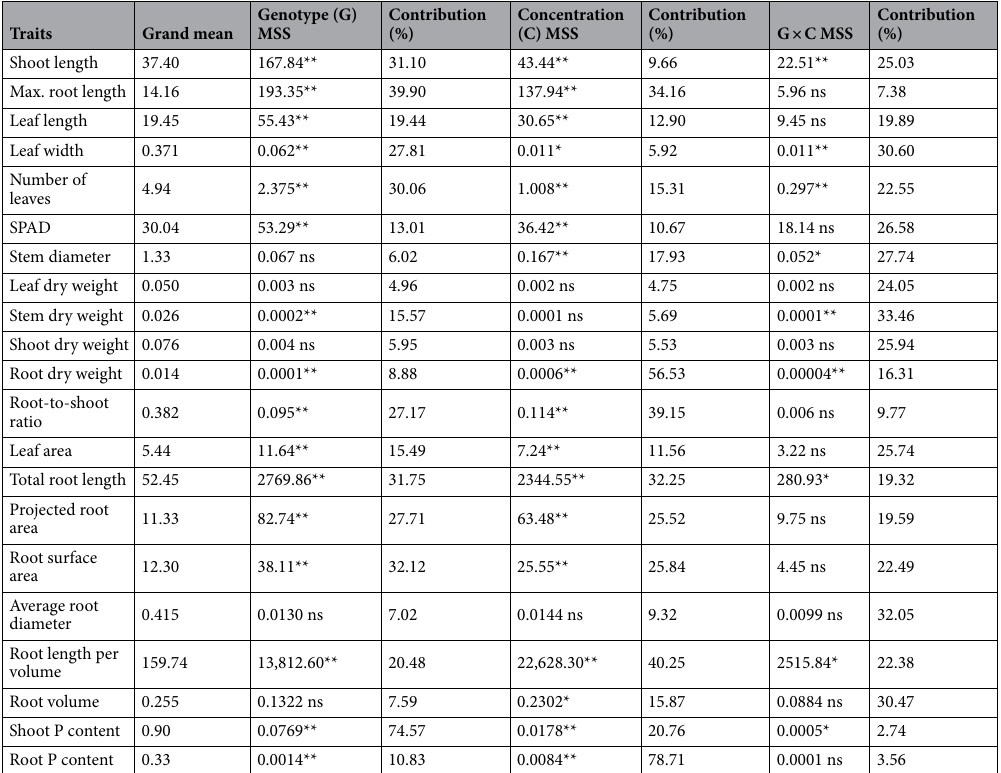
Table 1. Analysis of variance for various traits across different concentrations of phosphorus at 14 d. *Significant at 0.05 level of probability. **Significant at 0.01 level of